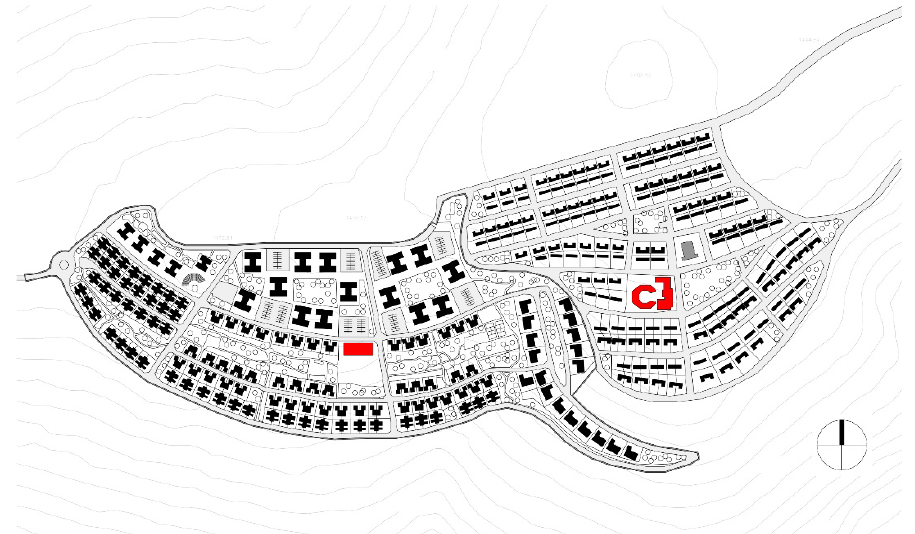
Figure 1. The Gacuriro Valley Satellite Settlements. Drawing by Manlio